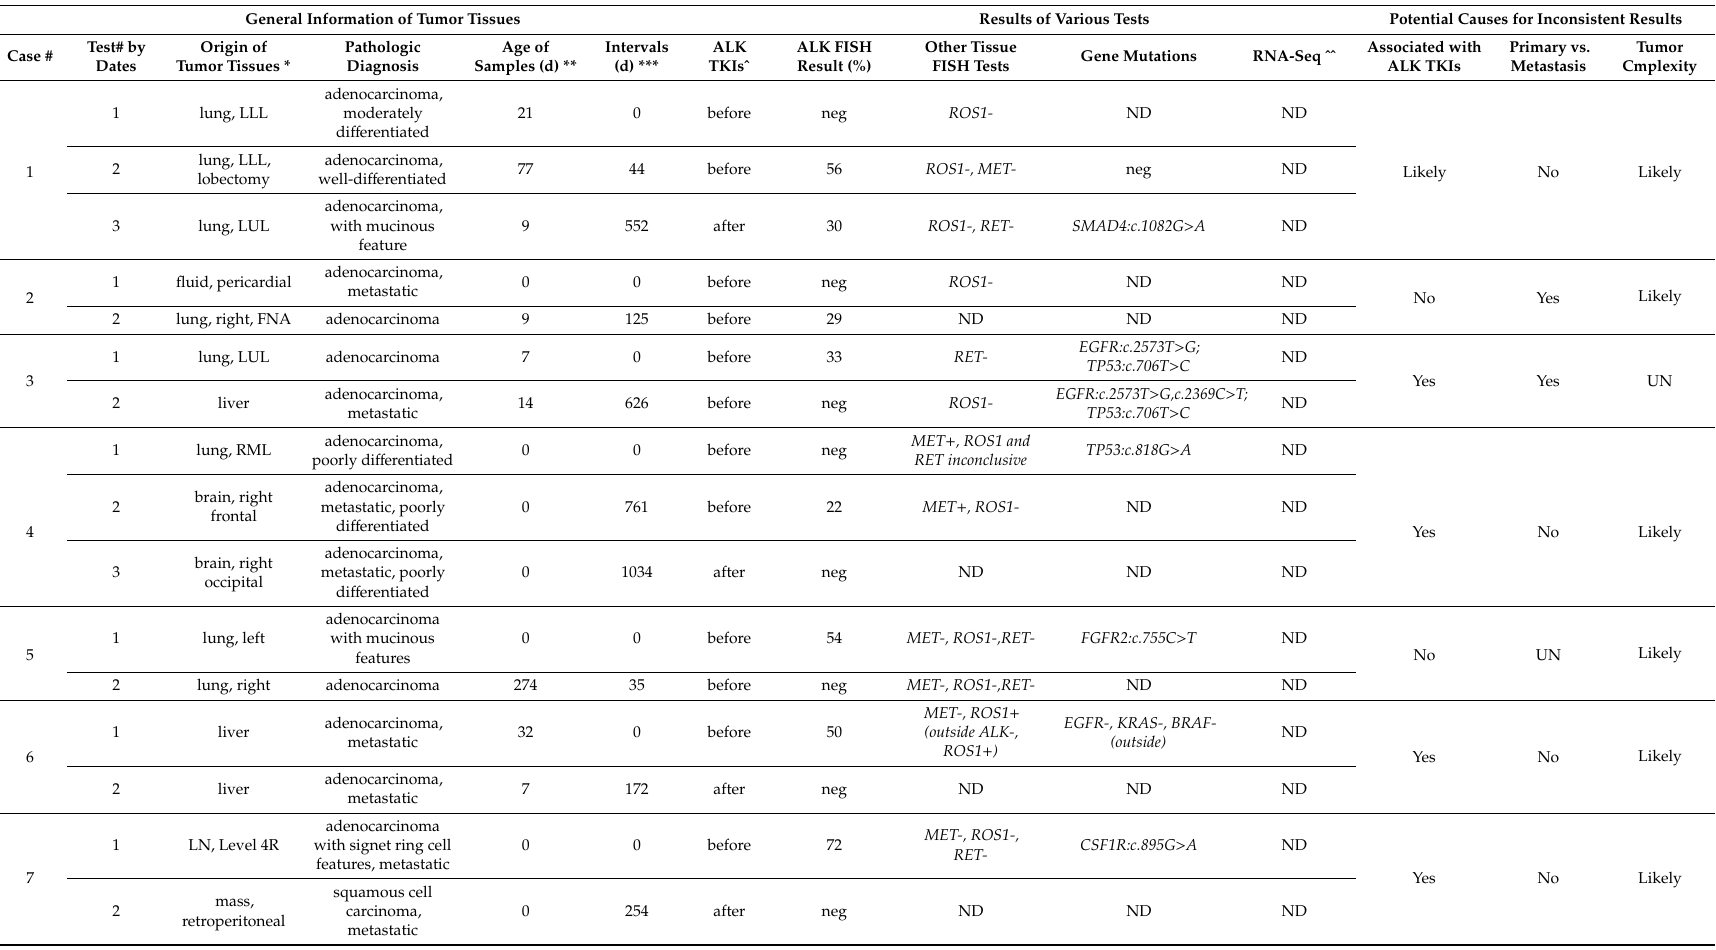
Table 2. Information on tumor tissues, test results and potential causative causes for inconsistent intersample ALK FISH